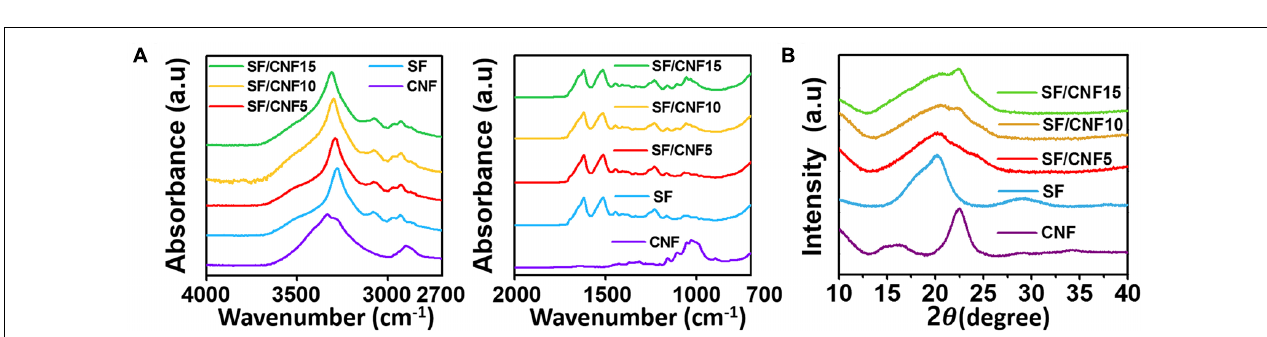
FIGURE 5 | Characteristics of CNF, nonwoven SF, and SF/CNF composites with various amounts of CNFs: (A) FTIR spectra, (B) XRD pattern.